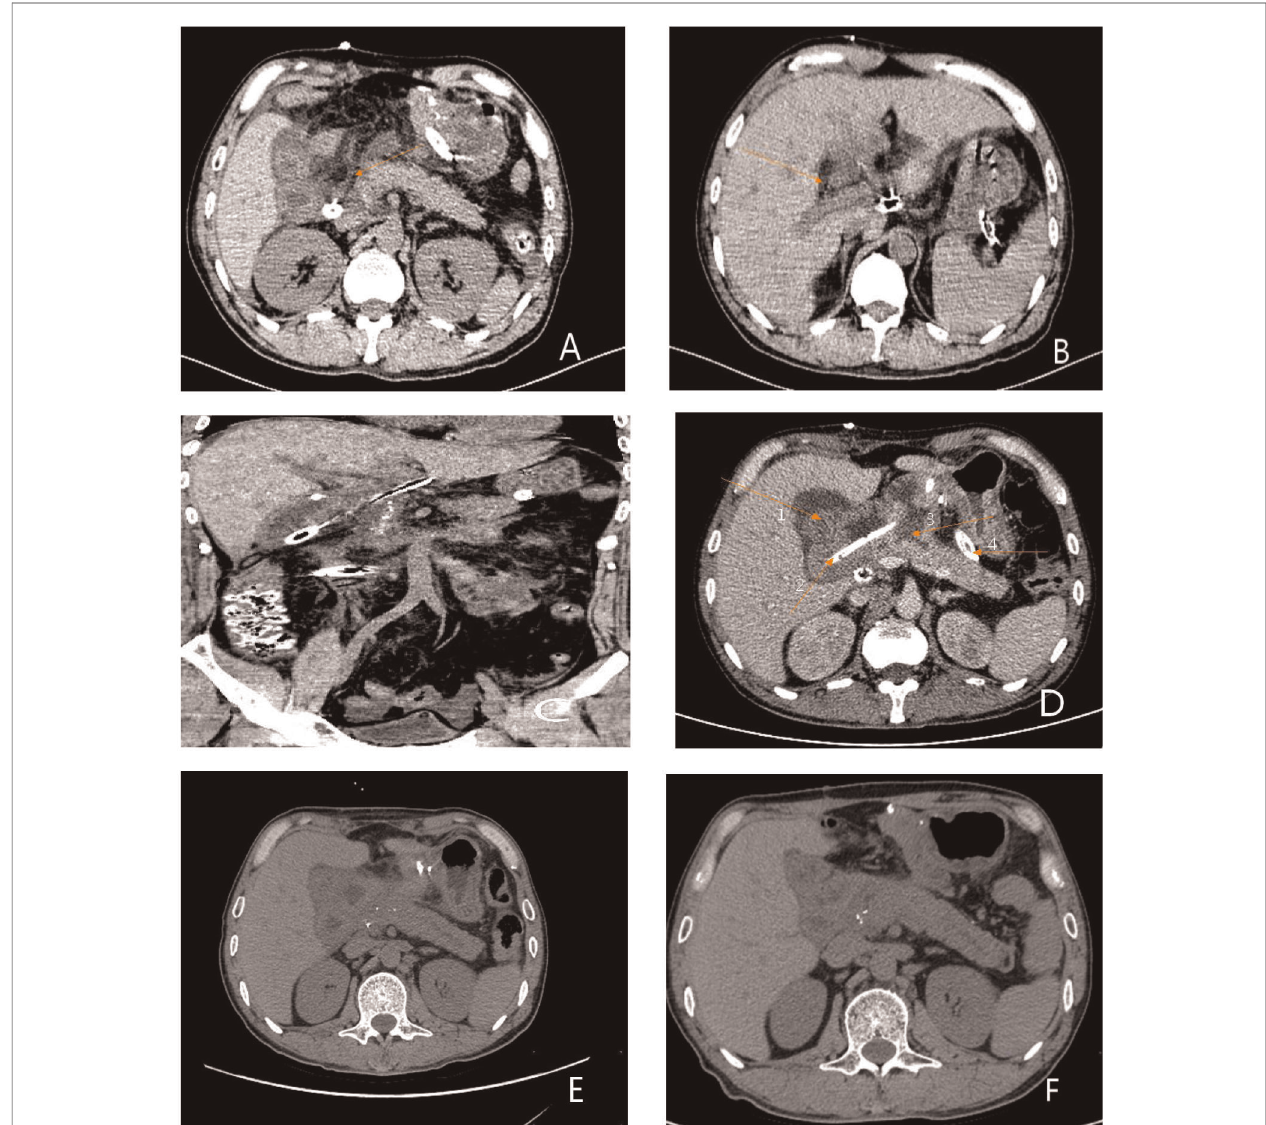
FIGURE 5 | Postoperative CT results. ( A ) Plain CT scan of the whole abdomen on the 3rd postoperative day. The arrow shows the pancreaticojejunostomy. ( B ) Full abdominal CT reexamination on day 3 postoperatively. The arrow showed the pancreaticojejunostomy. ( C ) Full abdominal CT reexamination on day postoperatively showing the entire pancreaticoduodenectomy area. ( D ) Plain CT scan of the whole abdomen on day 11 postoperatively. Arrow 1 shows the biliary and intestinal anastomosis, arrow 2 shows the indwelling open- fi eld decompression tube intraoperatively, arrow 3 shows the pancreaticojejunostomy, and arrow 4 shows the indwelling three-cavity irrigation and drainage tube intraoperatively. ( E ) Plain CT scan of the whole abdomen 1 month after surgery showing no obvious abnormalities. ( F ) Plain CT scan of the whole abdomen 3 months after surgery indicating good